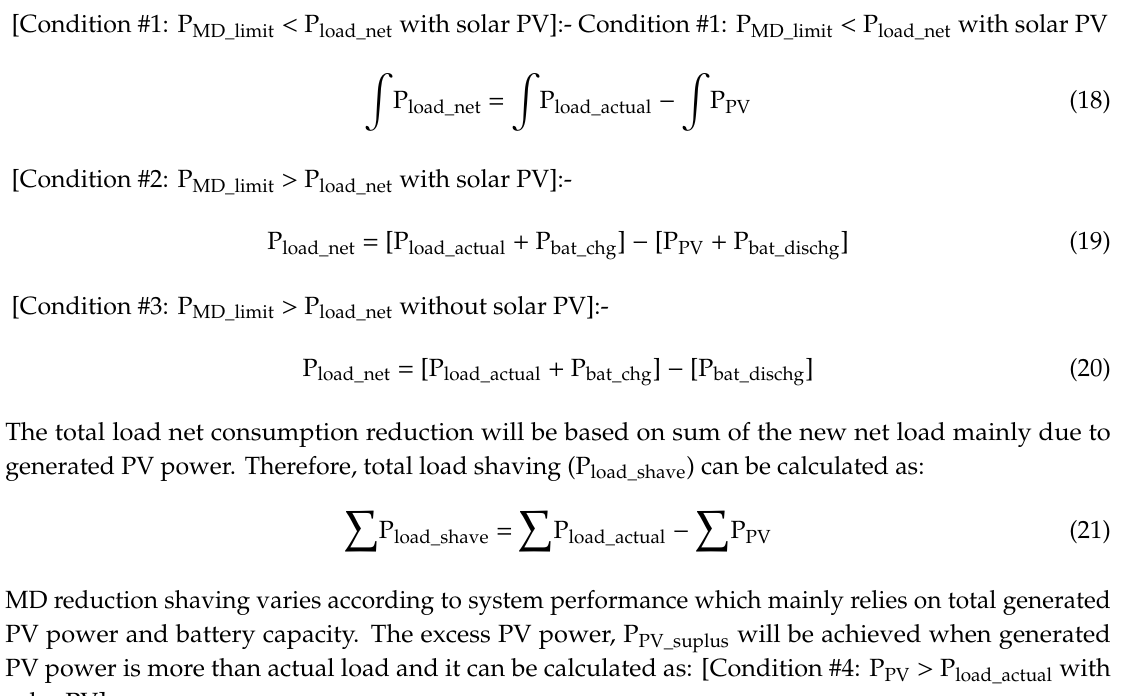
Table 8. Detail of the components.